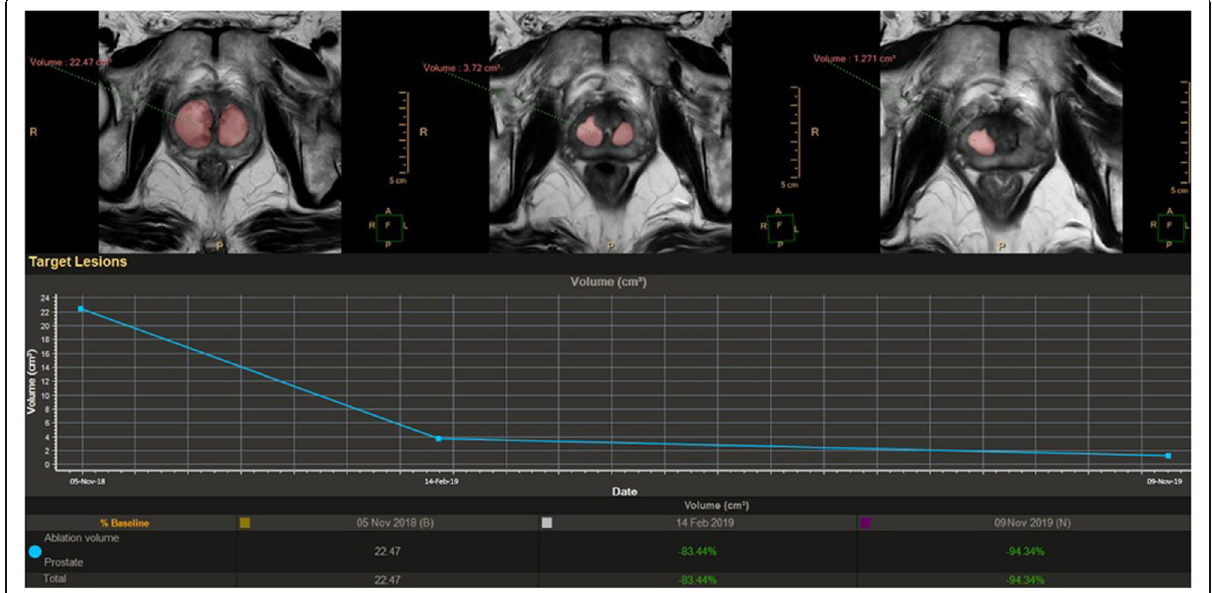
Fig. 5 A representative case of automatic segmentation software analysis (Philips IntelliSpace Portal 7.0 Multi Modality Tumor Tracking) of fluid- filled postablation cavities and prostate volumetric trend on axial T2-weighted sequences in a 58-year-old patient between (from left to right) month 1, month 3, and month 12. The right necrotic cavity showed a volumetric reduction of 83.8% between month 1 and month 3 and an 88.8% reduction between month 3 and month 12. The volume of the left cavity showed a reduction of 80.8% between month 1 and month 3, becoming no longer detectable at month